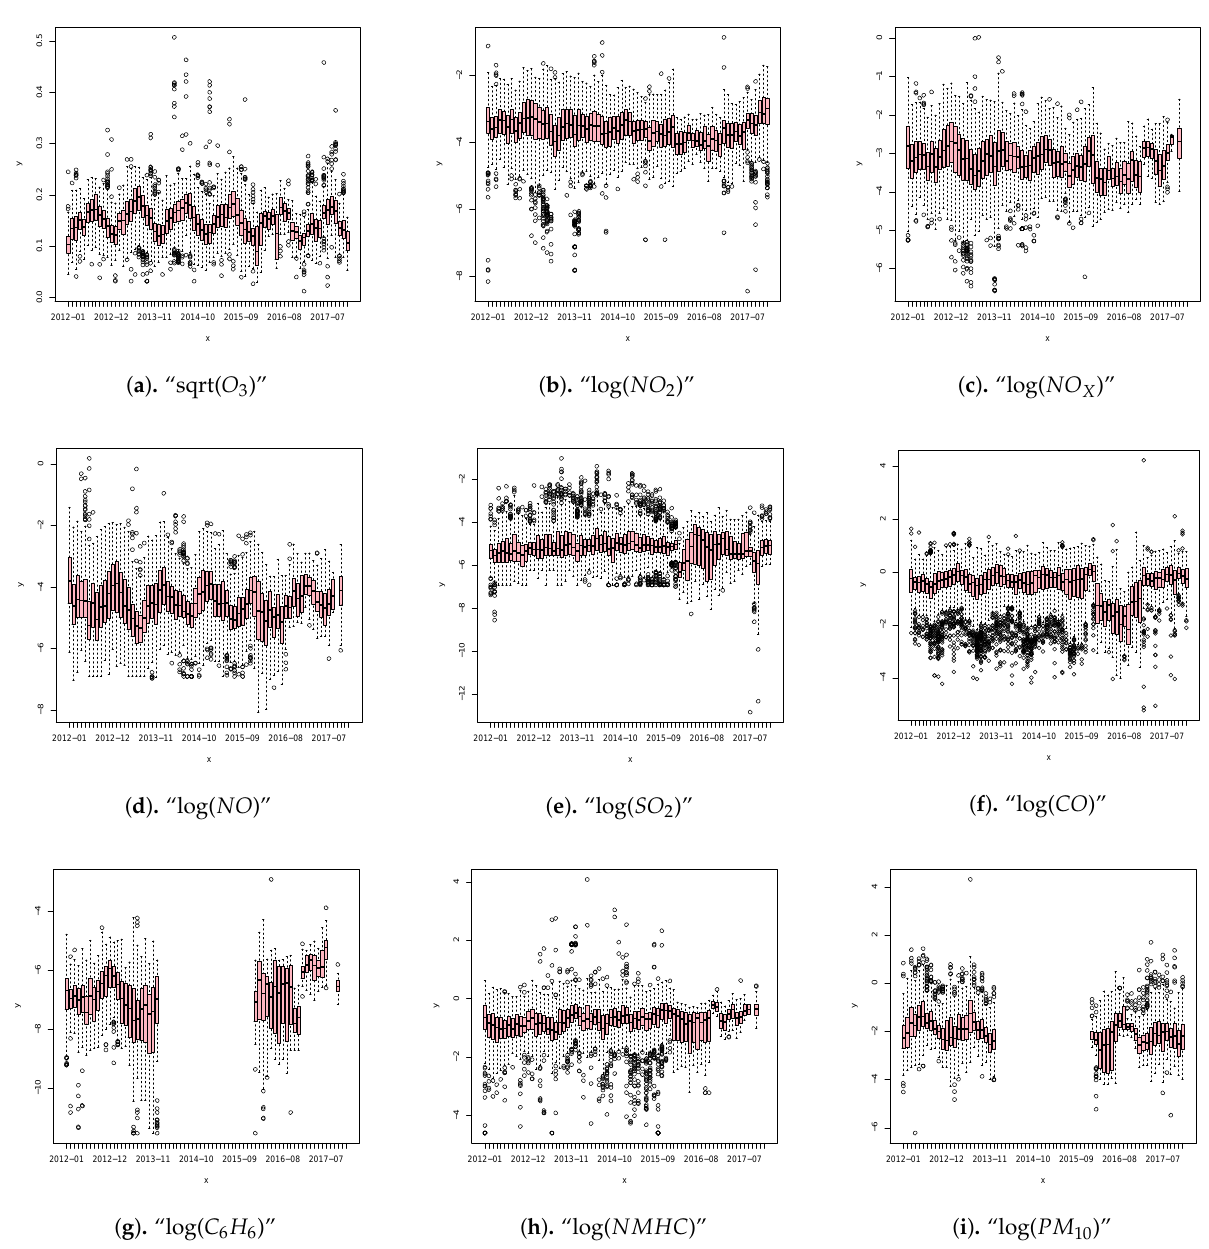
Figure 7. Box plot of the monthly pollutant concentration after suitable transformation from January 2012 to December